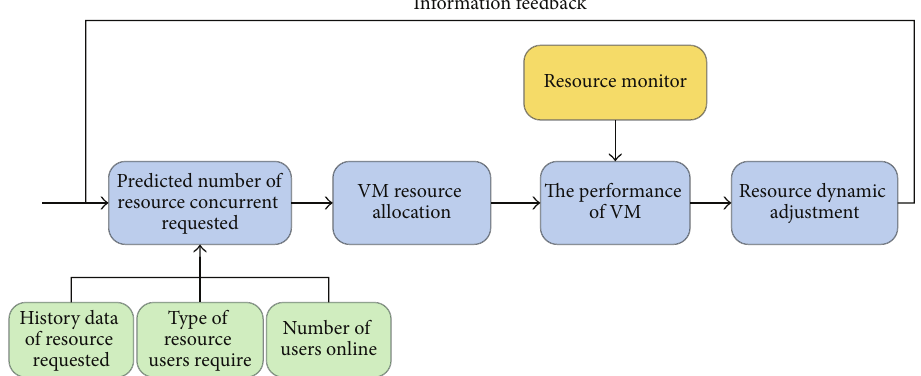
Figure 1: Dynamic configuration of system